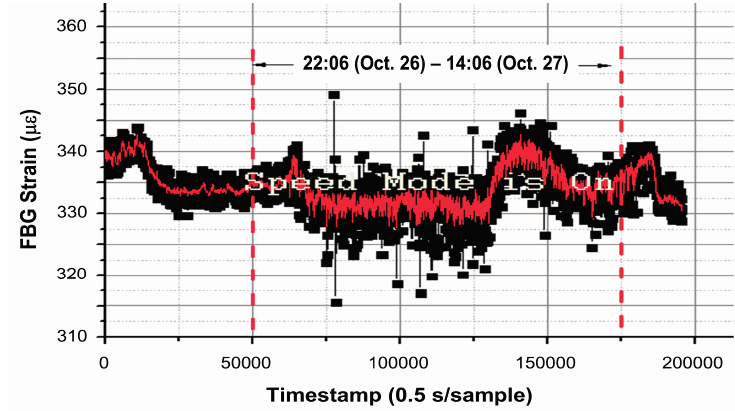
Figure 14. Experimental results of FBG strain with consideration of the wind and in case of no ice